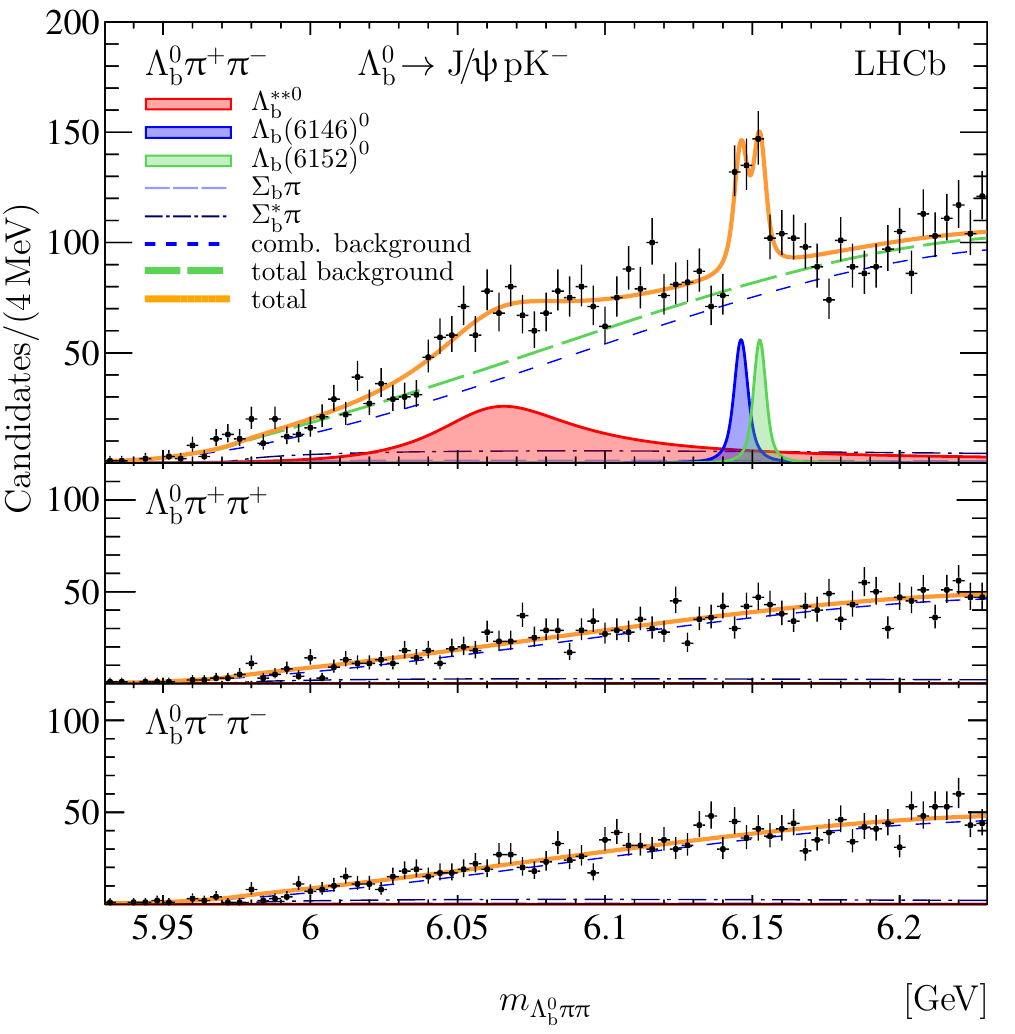
(cid:25) + (cid:25) (cid:0) , (middle) (cid:3) 0 (cid:25) + (cid:25) + and (bottom) (cid:3) 0 b b